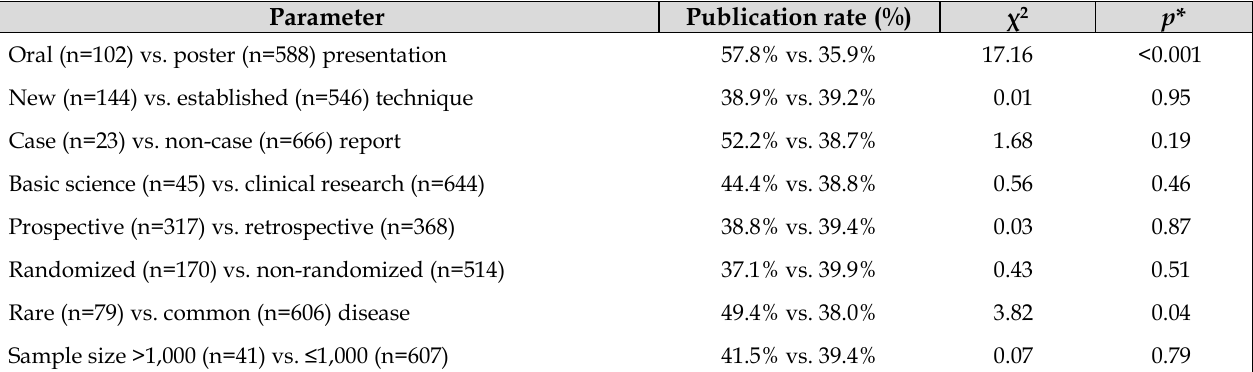
Table 2 Differences in publication rates of abstracts based on various factors Parameter